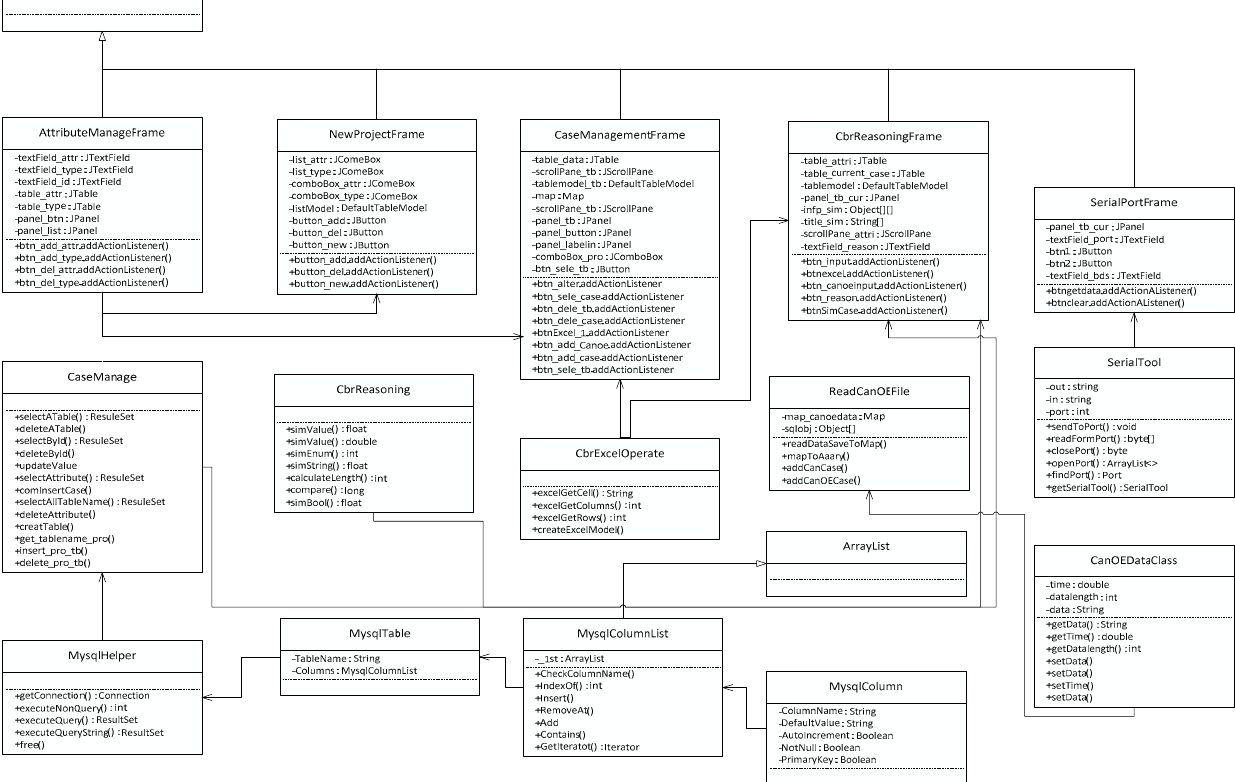
Figure 5. Outline of the class module.